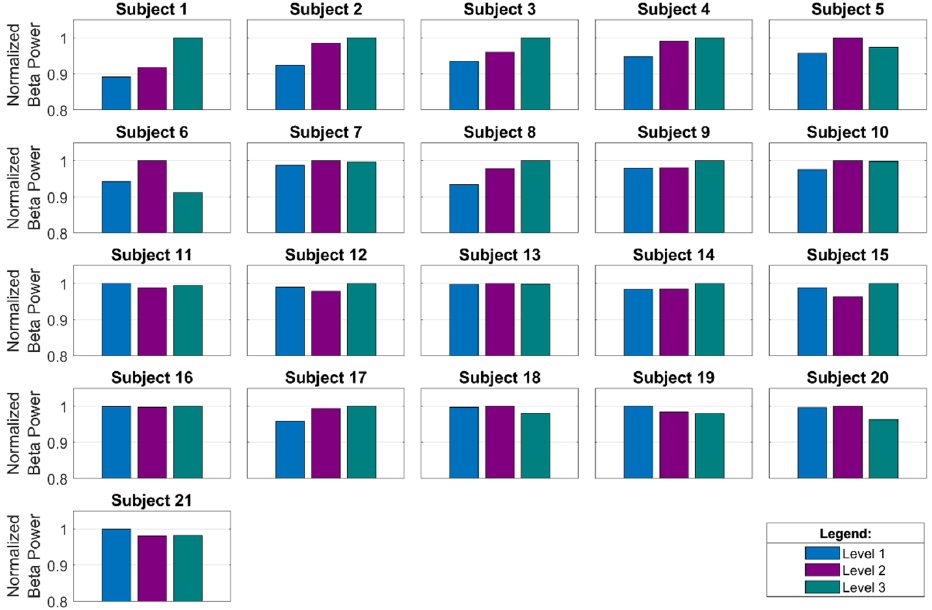
Figure 10. The normalized average beta activity in the game levels.